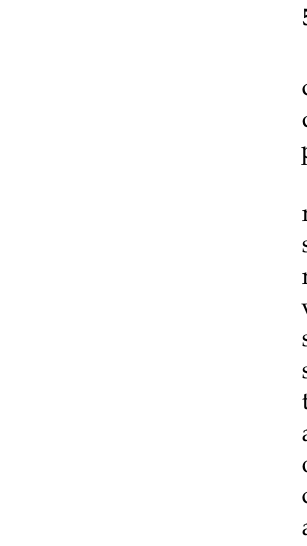
Table 12. Voxel number, t -score, coordinates and deactivated brain location in deactivation area. Standard Coordinates Number of Deactive Voxels t -Score p -Value (x,y,z) (mm) Note: L represents the left